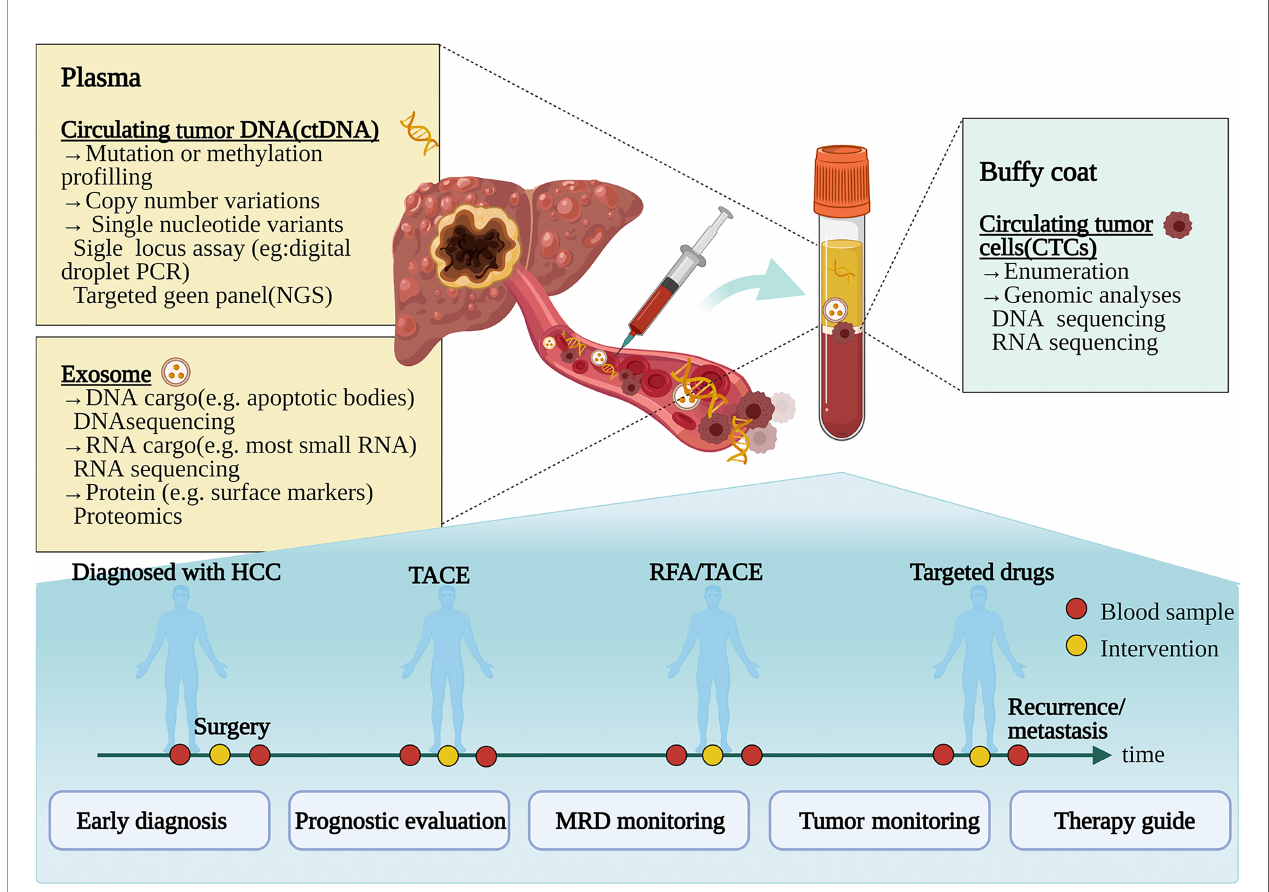
FIGURE 1 | Clinical application pattern of liquid biopsy in patients with hepatocellular carcinoma. Tumor composition analyses, such as circulating tumor cells, circulating tumor DNA, and exosomes, are released by tumors to the bloodstream. During the various treatments such as surgery, transcatheter arterial chemoembolization (TACE), radiofrequency ablation (RFA), and targeting molecular treatment, liquid biopsy can be used for diagnosis, prognosis, and progress monitoring of HCC patients. NGS, next-generation sequencing; MRD, minimal/molecular residual disease. Figure 1 created in BioRender